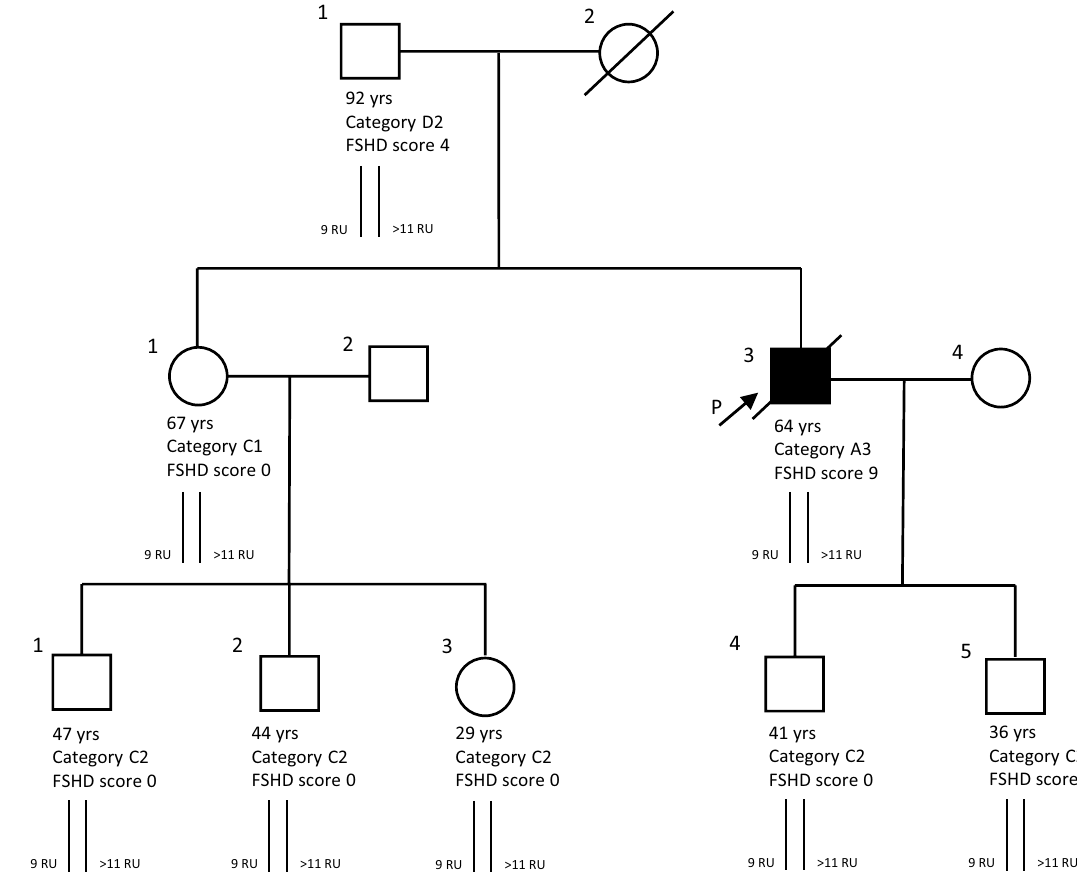
Figure 3. Pedigree Family 952. Age (years) at clinical evaluation, FSHD score (sc), CCEF clinical category, D4Z4 molecular haplotype are reported. Individuals I.1, II.1, II.3, III.1, III.2, III.3, III.4, III.5 carry one D4Z4 allele with 9 RU associated with the qA polymorphism. Individual II.3 developed FSHD at 45 years in the period following three cycles of